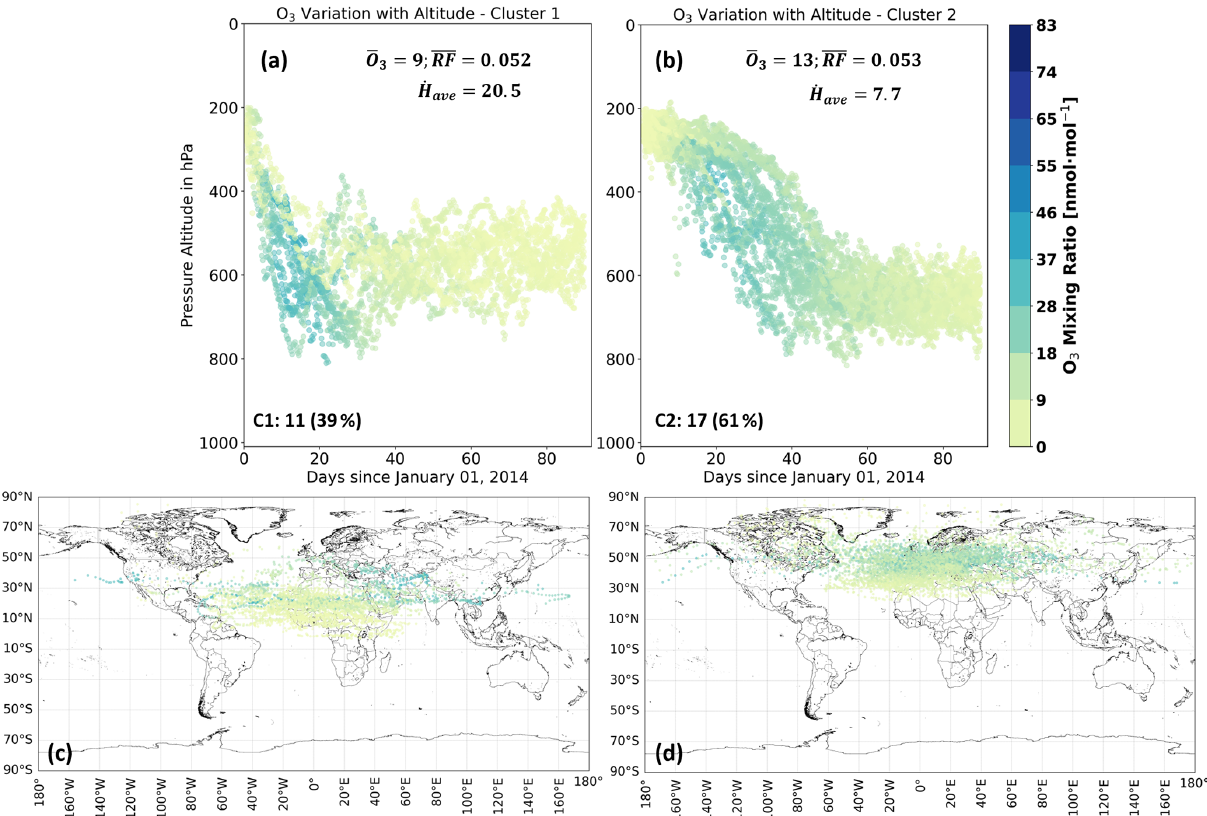
Figure 7. (a) Vertical profile of Cluster 1 (C1) of NO x transport pathways over 90d following an emission on 1 January 2014 for N. America. The color bar represents the mean O 3 disturbance in nanomoles per mole (nmolmol − 1 ) caused by the median trajectory. Each cluster label is followed by the number of median trajectories that it comprises both in absolute and relative terms (bottom left of each figure). The mean rate of descent for a 90d period in hectopascals per day (hPad − 1 ) for all median trajectories in a cluster is defined as ˙ H ave . The cluster radiative forcing contribution in milliwatts per square meter (mWm − 2 ) is labeled as RF, and the mean O 3 disturbance in nanomoles per mole (nmolmol − 1 ) is O 3 . Panel (b) represents the same quantities but for Cluster 2 (C2), panel (c) is the horizontal distribution of C1 and panel (d) is the horizontal distribution of